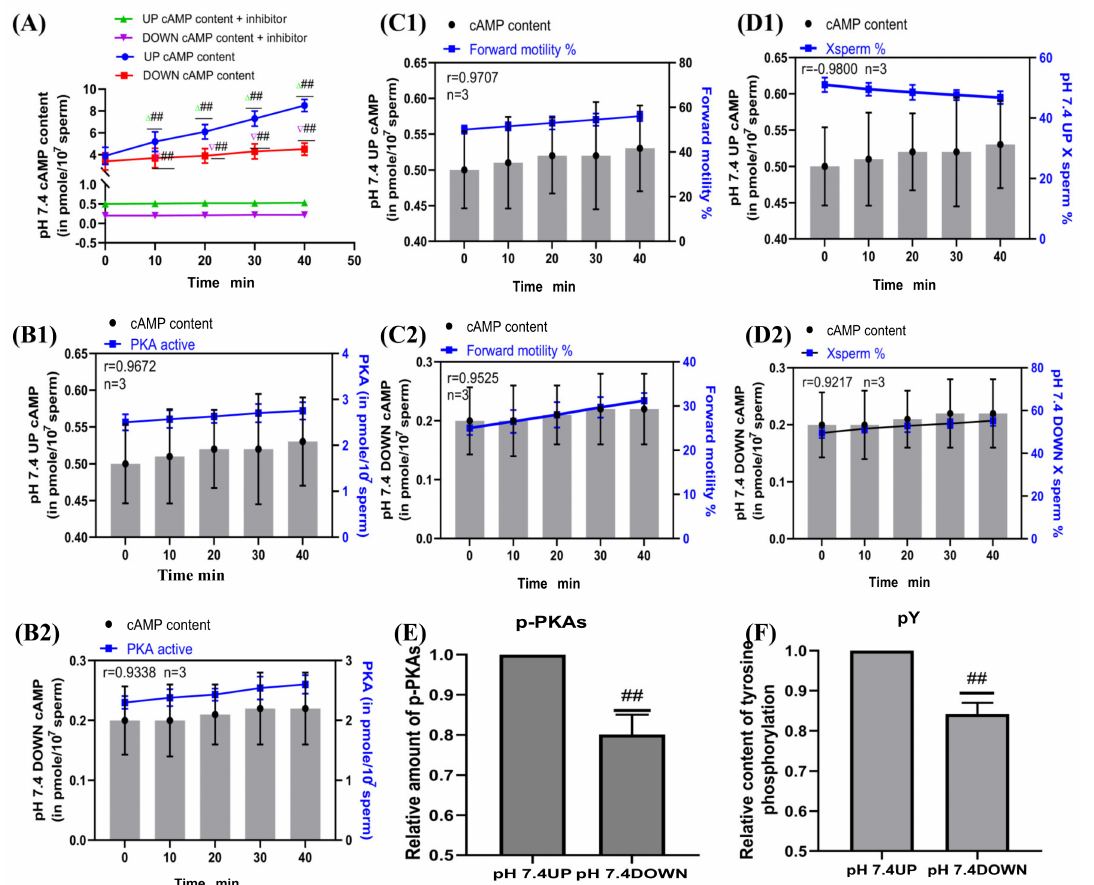
Figure 7. Sperm motility following inhibition of cAMP content. ( A ) Changes in cAMP content in sperm after SQ22536 supplementation. ( B1 , B2 ) Correlation between cAMP content and PKA protease activity of sperm. ( C1 , C2 ) cAMP content was correlated with the proportion of forwardly motile spermatozoa. ( D1 , D2 ) Correlation between cAMP content and the proportion of X-chromosome- bearing sperm. ( E , F ) Statistics of p-PKAs and pY content in sperm after the addition of cAMP inhibitors. Results are expressed as mean ± SEM, n = 3 experiments. Two-way ANOVA and Bonferroni’s multiple comparison test. (##) indicates significant differences between the two groups ( p <